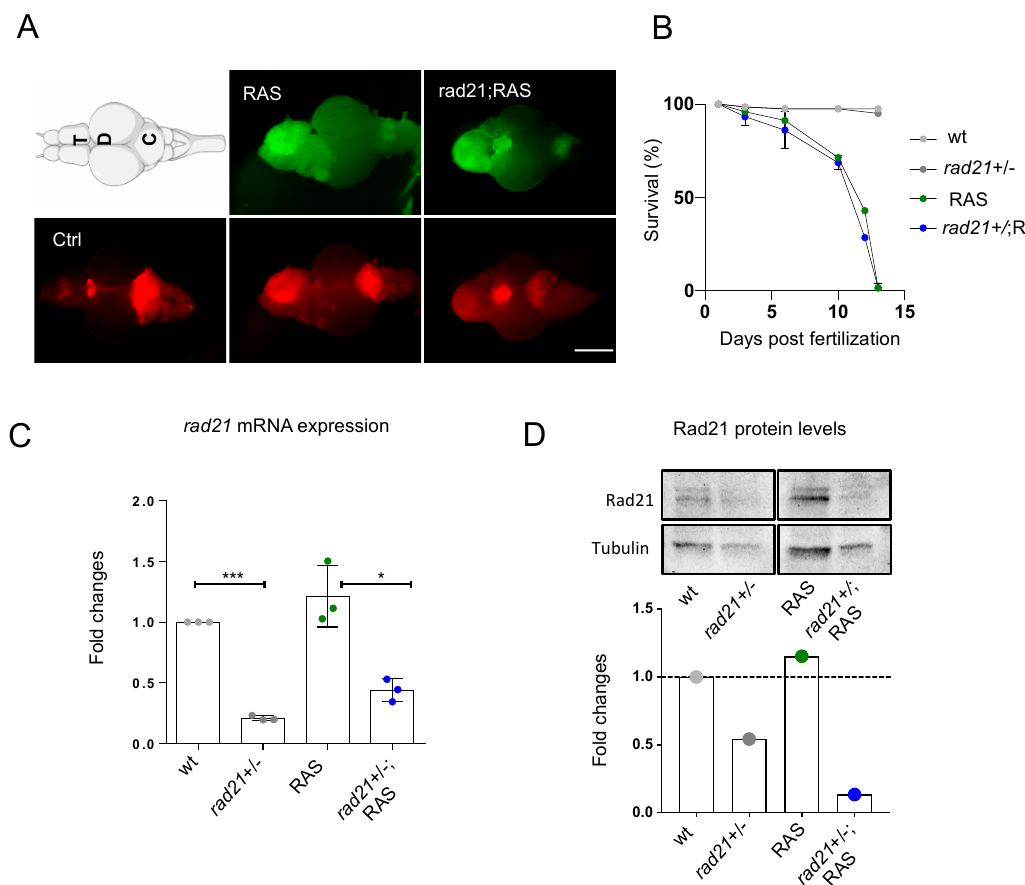
Figure 1. Rad21 heterozygous fish develop brain tumors with the same frequency and location than wt. ( A ) Representative images of zebrafish RAS and rad21;RAS brains used for this study. The expression of UAS:eGFP-HRAS V12 was induced in a population of brain progenitor cells using the driver line zic:GAL4 (visualized through mCherry expression, bottom panel). Tumor formation is visualized through eGFP expression in 1-month-old fish (upper panel). The location of tumors appears to be similar in both RAS and rad21;RAS fish. Scale bar: 0.5 mm. T: telencephalon; OT: optic tectum; C: cerebellum. ( B ) Survival curve of RAS and rad21;RAS shows a very low survival rate (approx. 1%) for both genotypes n = 2 in control groups (gray dots) and n = 4 in tumor groups (blue and green dots). ( C ) Expression of zebrafish rad21a mRNA in controls and brain tumors measured by RT-qPCR. Values were normalized to rps11 mRNA levels; n = 3 in all groups; *** p < 0.001; * p < 0.05. ( D ) Rad21 protein levels in Western blot and relative quantification. Rad21 levels are reduced in control (2nd lane) and tumor brains (4th lane) from rad21a hi2529Tg /+ fish compared to the wild type (fold changes). Values were normalized to tubulin levels.